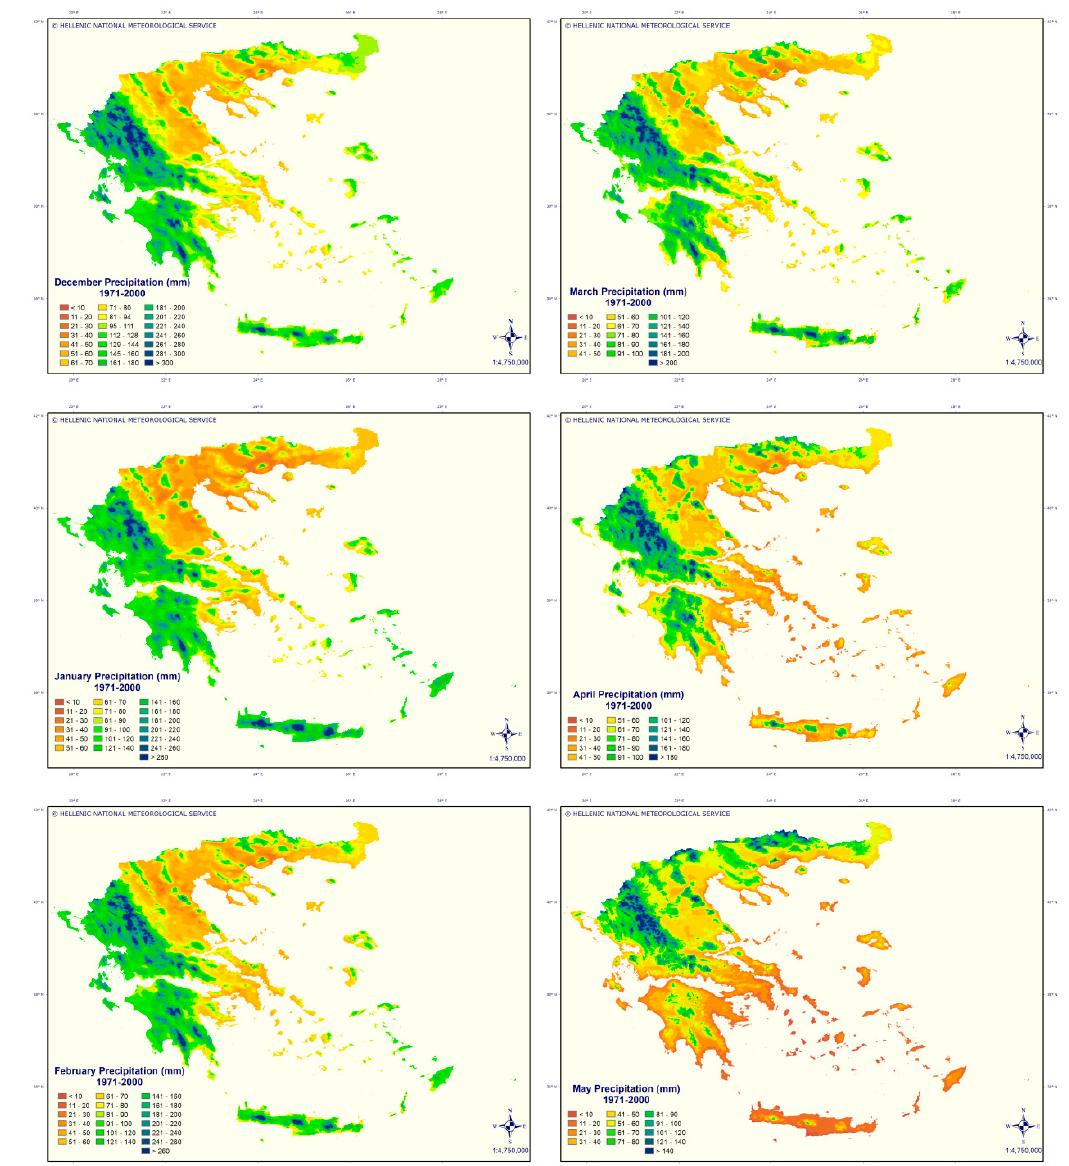
Figure 10. Precipitation maps for the period 1971–2000 for DJF months (left column) and MAM months (right column).